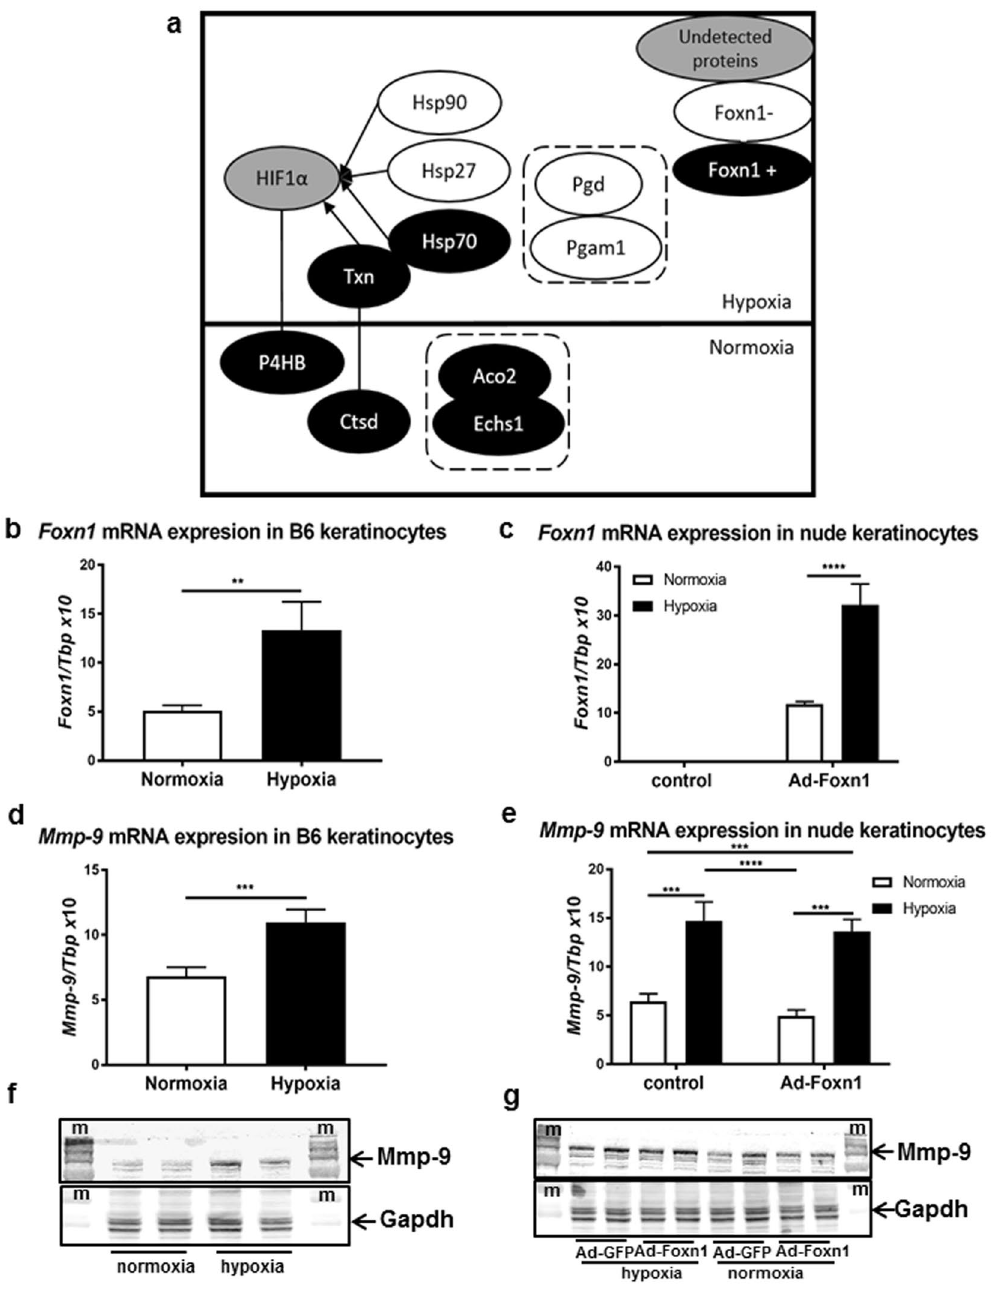
Figure 3. Foxn1 overexpression in keratinocytes affects proteins that regulate the hypoxia/normoxia response. Schematic representation of molecular cross-talk between proteins exhibiting hypoxic or normoxic characteristics, according to proteome profiling results, and induced in keratinocytes transfected with Ad-Foxn1 (black colour) or Ad-GFP (control; white colour) ( a ). Grey colour indicates proteins that were not detected in the analysis but link identified proteins ( a ). Foxn1 mRNA expression in primary cultures of B6 keratinocytes ( b ) and Ad-Foxn1 or Ad-GFP (control)-transfected nude keratinocytes ( c ) cultured under normoxic (21% O 2 ) or hypoxic (1% O 2 ) conditions. Corresponding Mmp-9 mRNA ( d ) and Mmp-9 protein ( f ) expression in keratinocytes isolated from B6 mice and Mmp-9 mRNA ( e ) and Mmp-9 protein ( g ) expression in nude keratinocytes transfected with Ad-Foxn1 or Ad-GFP (control) cultured under normoxic (21% O 2 ) or hypoxic (1% O 2 ) conditions. Values are the mean ± SD; ** p < 0.01, *** p < 0.001, **** p < 0.0001; m – molecular size